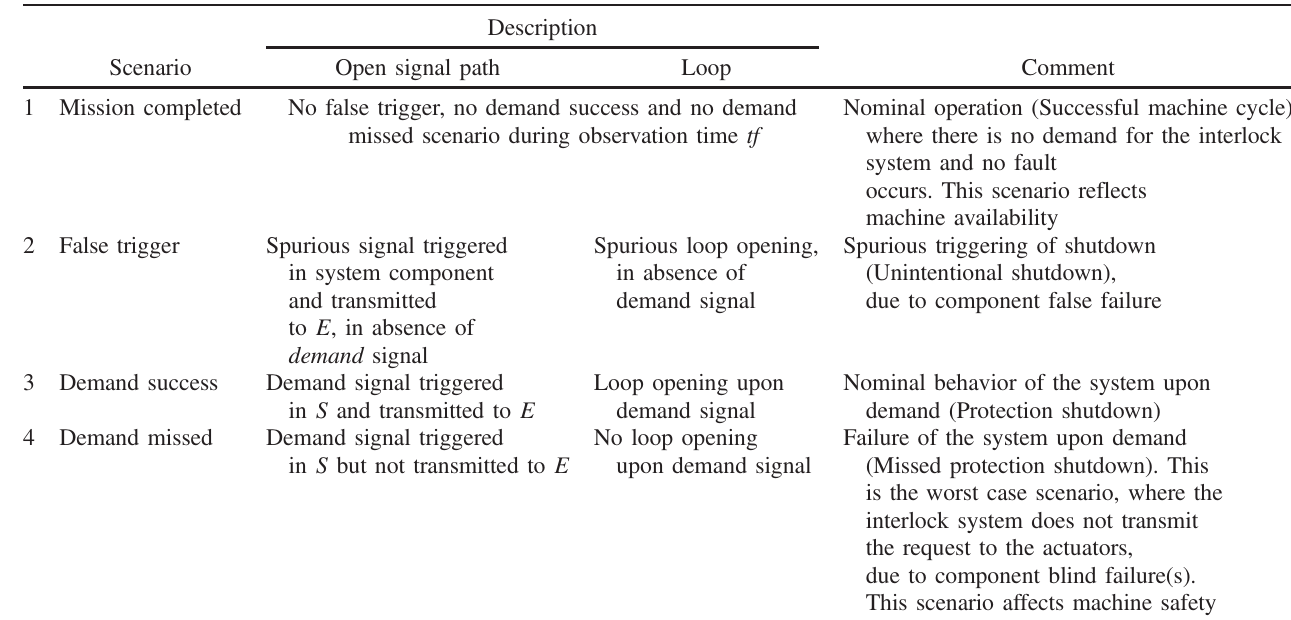
TABLE I. Definition of scenarios.